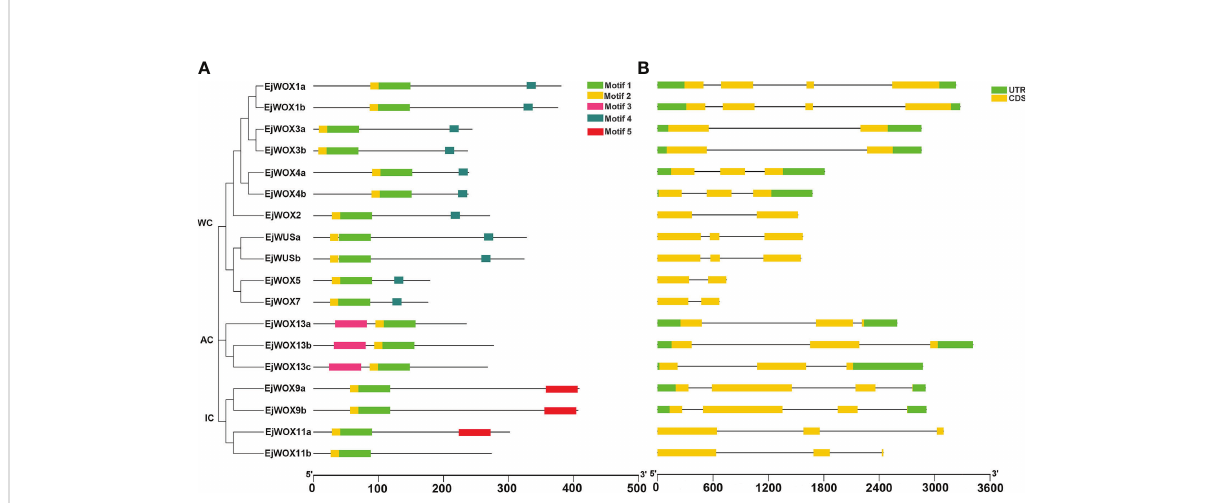
FIGURE 4 Conserved motif and gene structure analysis of loquat WOX genes. (A) Conserved motifs in EjWOX proteins are represented by colored boxes. (B) UTRs, exons, and introns are represented by green squares, yellow squares, and gray lines, respectively. Black lines indicate length. WC, WUS clade. IC, intermediate clade. AC, ancient clade.